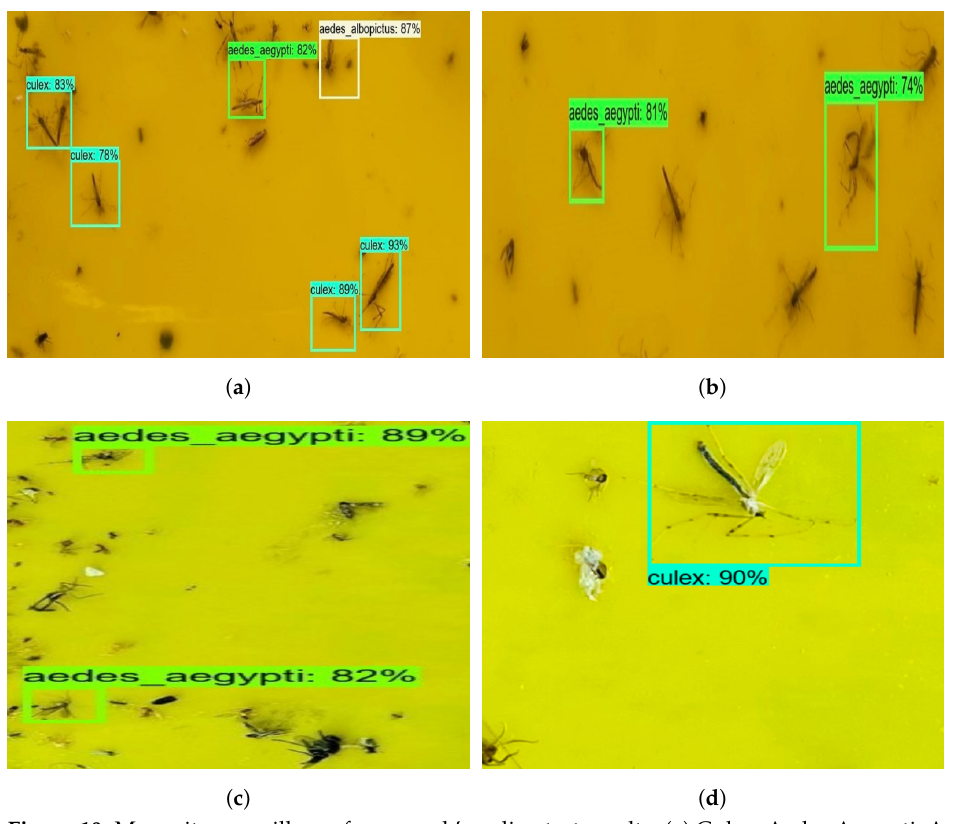
Figure 10. Mosquito surveillance framework’s online test results. ( a ) Culex, Aedes Aegypti, Aedes Albopictus. ( b ) Aedes Aegypti. ( c ) Aedes Aegypti. ( d ) Culex. Table 4. Statistical measure results of mosquito surveillance framework (online). Class Precision Recall F 1